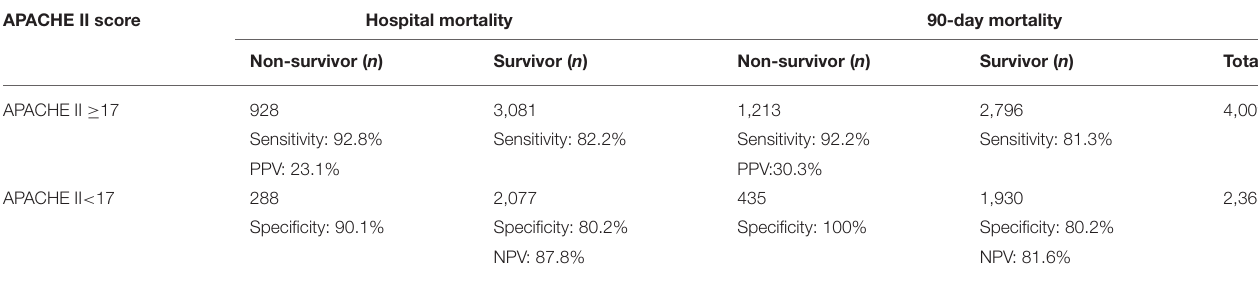
TABLE 2 | Prognostic performance of the third-day APACHE II in hospital mortality. APACHE II score Hospital mortality